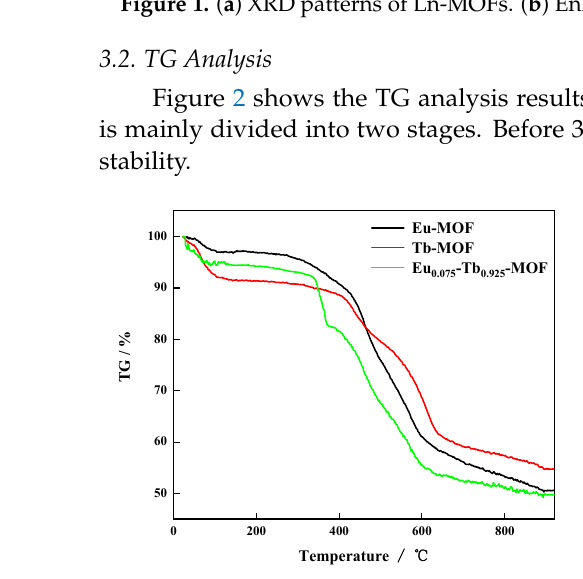
Figure 2. TG of Ln-MOFs. Figure 2. TG of